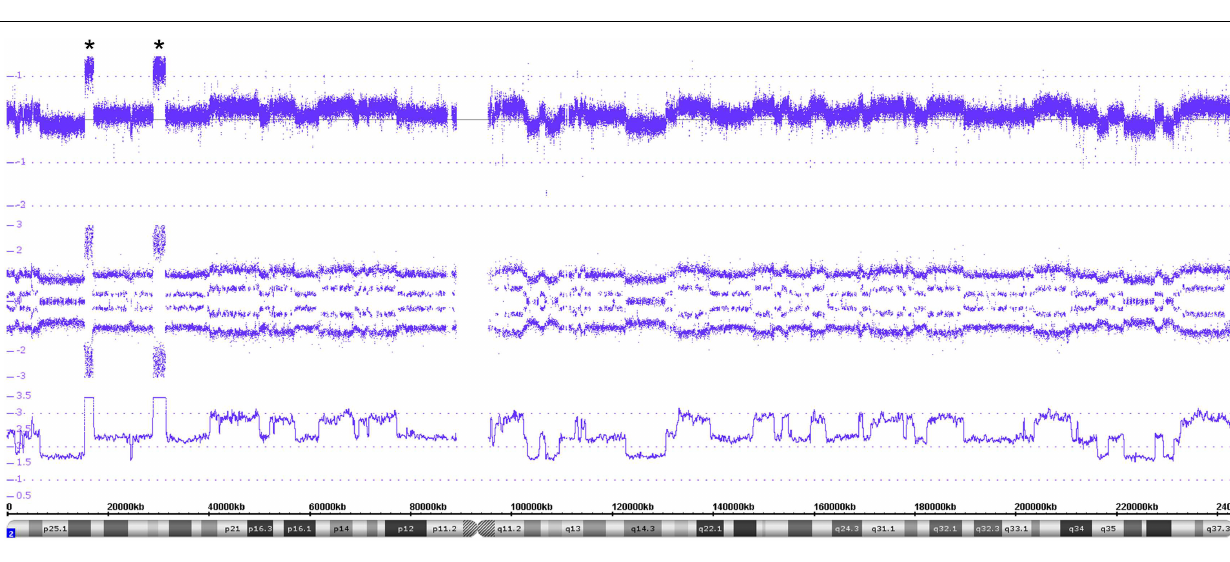
number of copy number variations represented in an oscillating copy number profile (visible in all tracks). In addition, the profile shows two amplicons including MYCN and ALK besides other genes (highlighted by